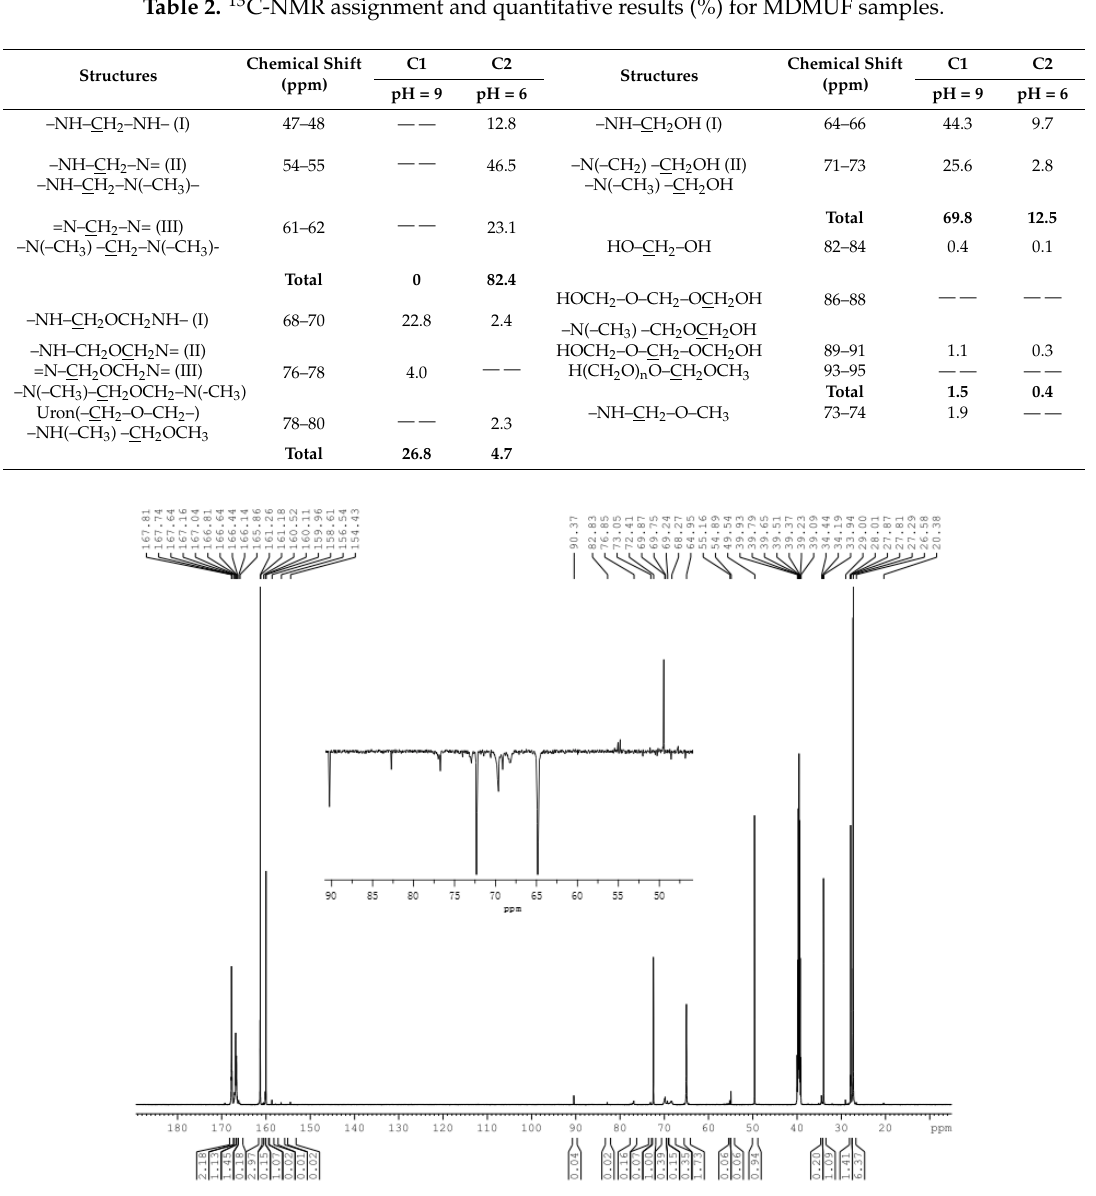
Table 2. 13 C-NMR assignment and quantitative results (%) for MDMUF samples.